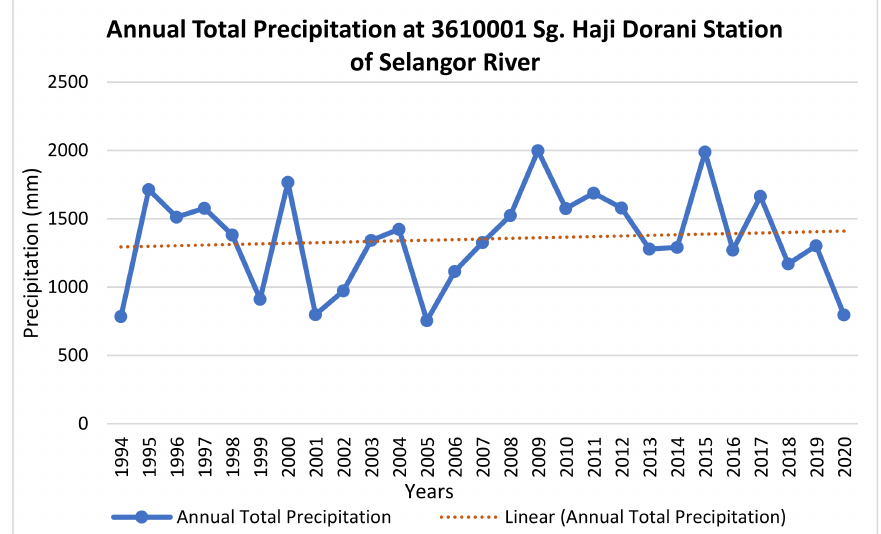
Figure 2. Annual Total Precipitation at Sg. Haji Dorani Station of Selangor